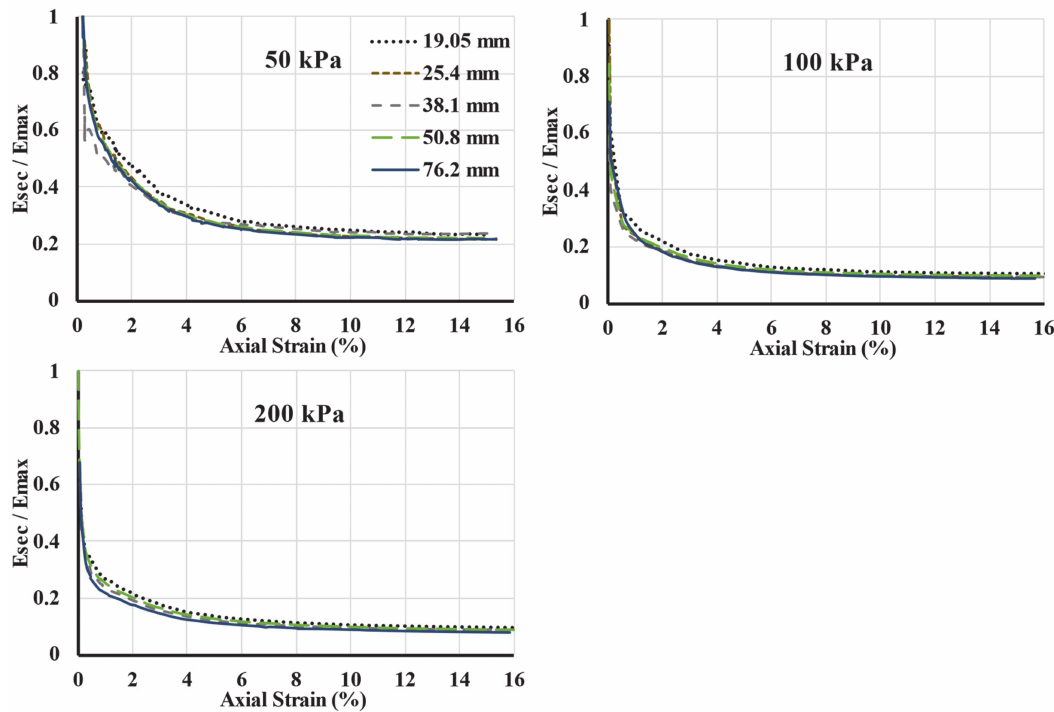
Figure 13. Stiffness degradation curves for TDA based on the strain